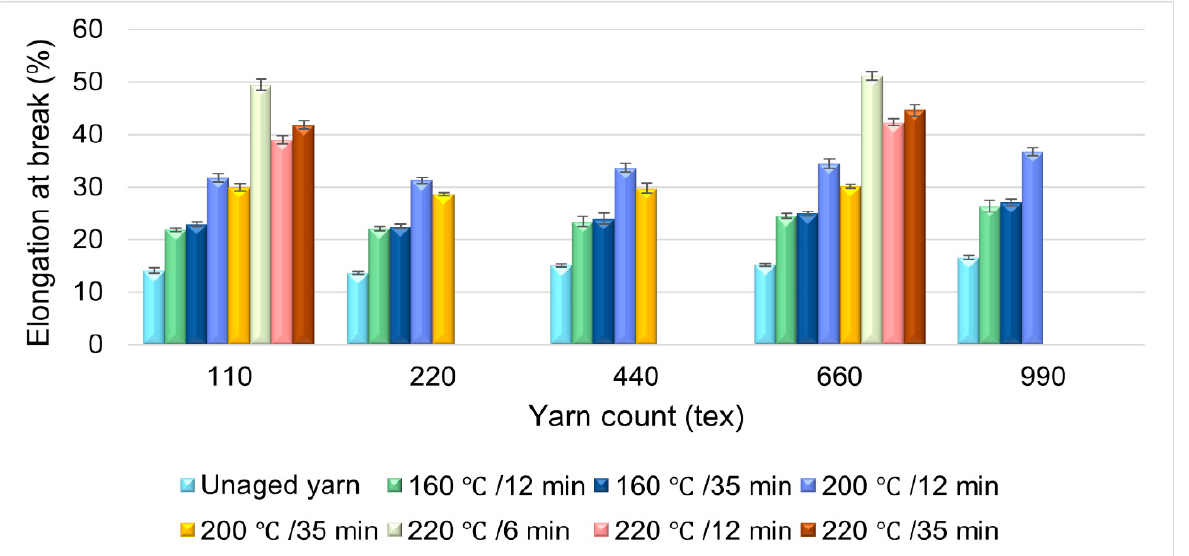
Figure 8. Effect of aging time on the percentage elongation of HT Polyester